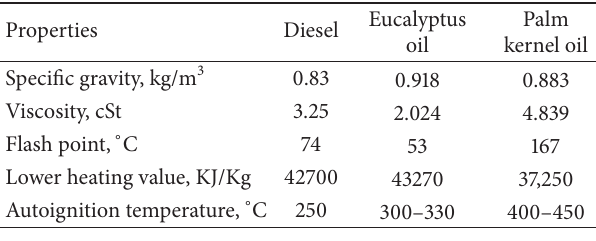
Table 4: Test rig